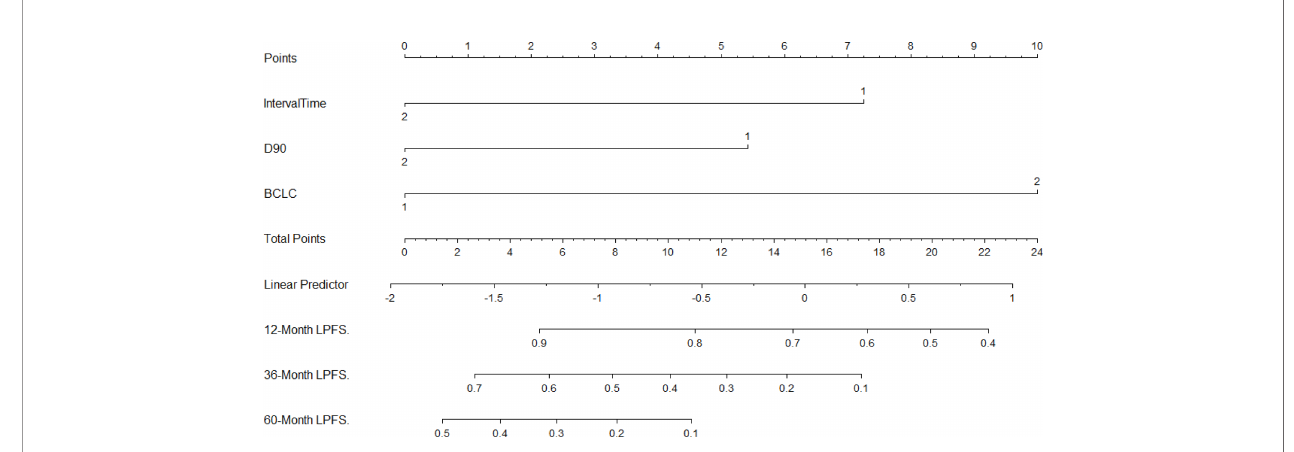
FIGURE 3 | Nomogram to predict the local recurrence after seed implantation (For Interval: 1 = “ ≤ 12 months ” , 2 = “ >12 months ” ; For D90 (Gy): 1 = “ < 140 ” , 2 = “ ≥ 140 ” ; For BCLC: 1 = “ A ” , 2 = “ B + C ”